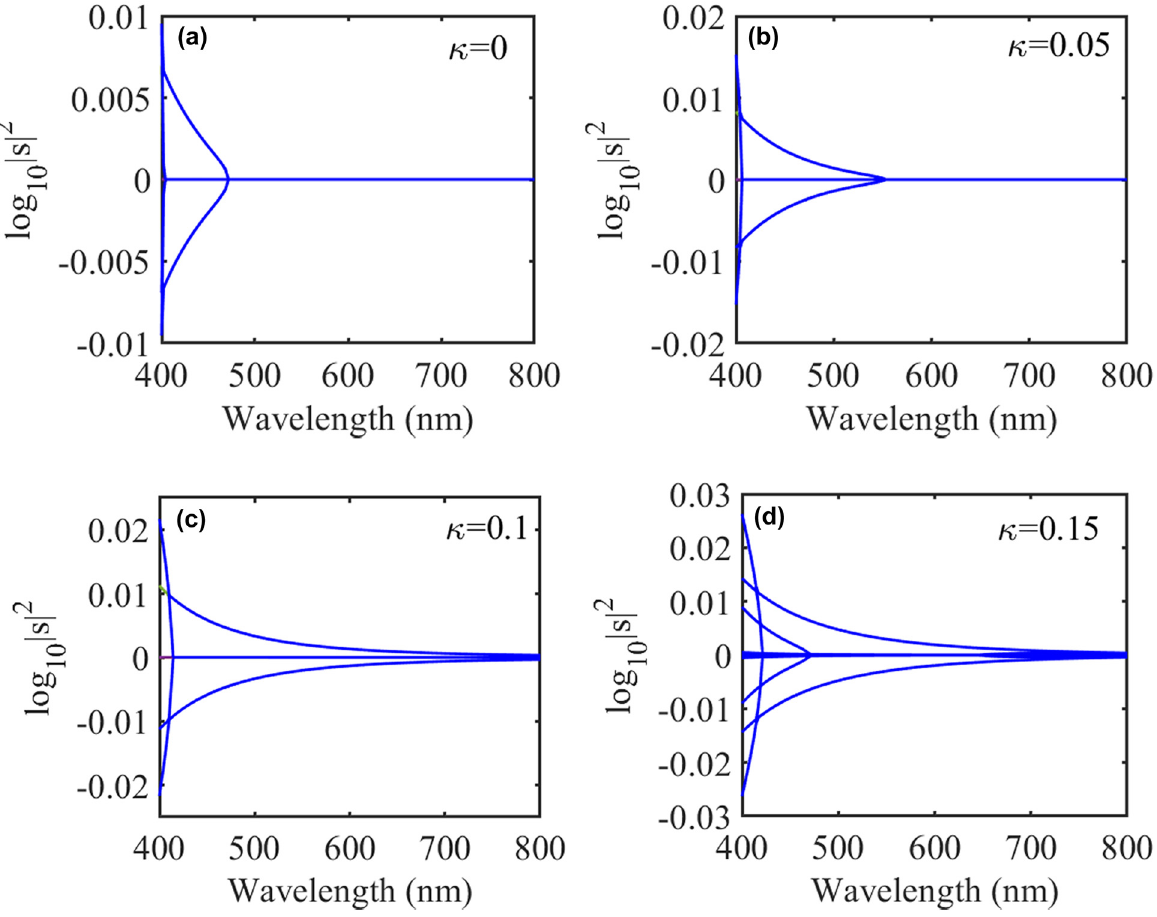
Figure 2: Semi-log plots of scattering matrix eigenvalues for the coupled PT-symmetric chiral nanospheres as a function of wavelength with chirality parameter κ = 0 (a), κ = 0 . 05 (b), κ = 0 . 1 (c), and κ = 0 . 15 (d). The non-Hermiticity parameter is δ = 0 .